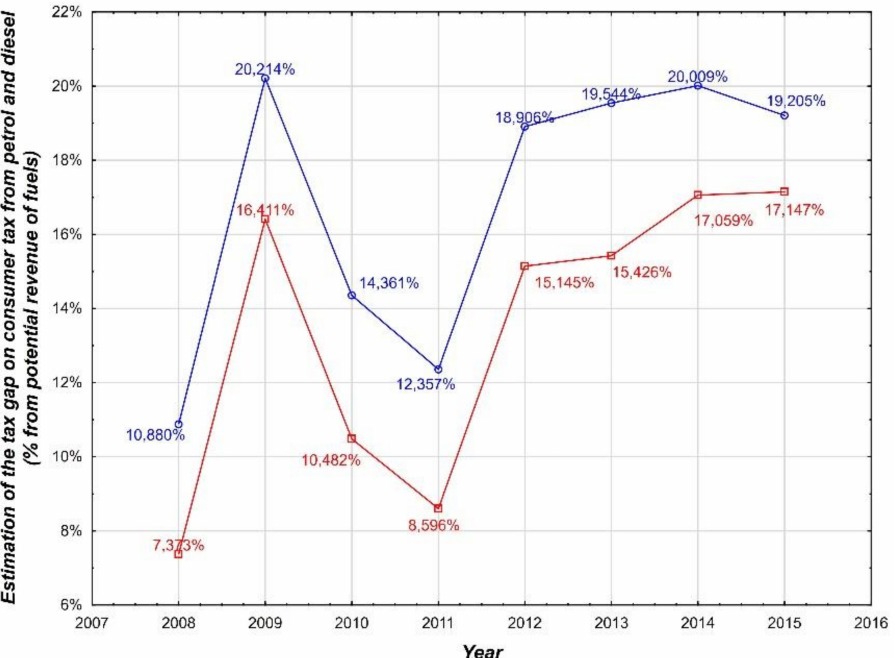
Figure 8. Estimation of the tax gap on the consumer tax from petrol and diesel from 2008 to 2015 (% from potential revenue of fuels).